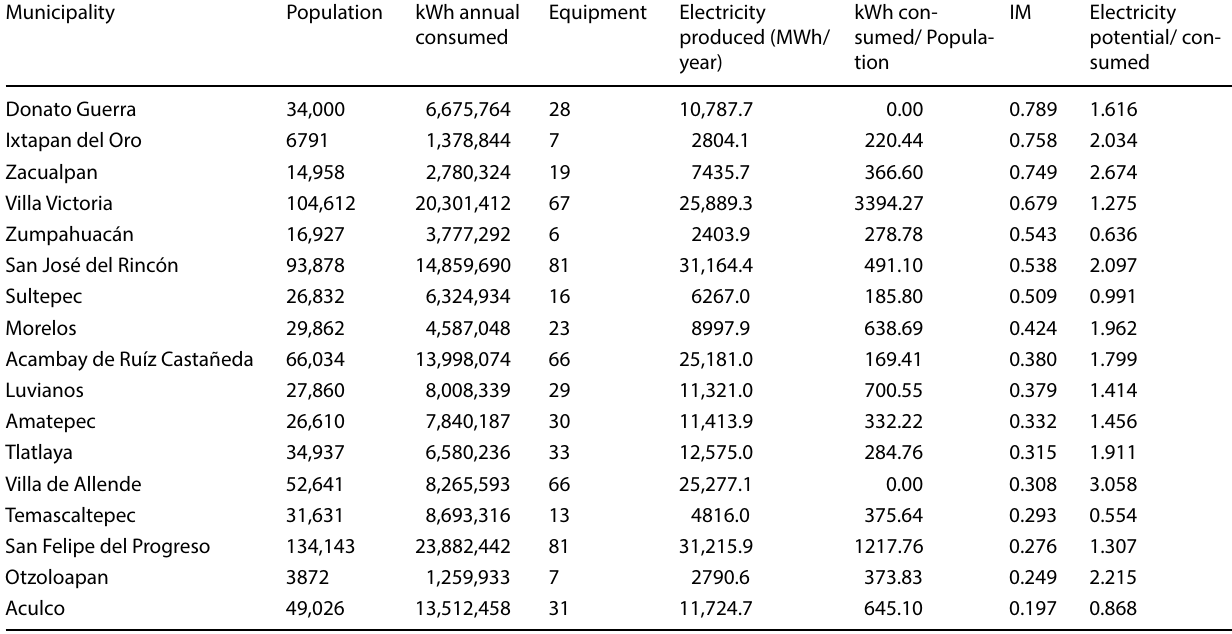
Table 11 Extract for Mexico state, municipalities sample Municipality